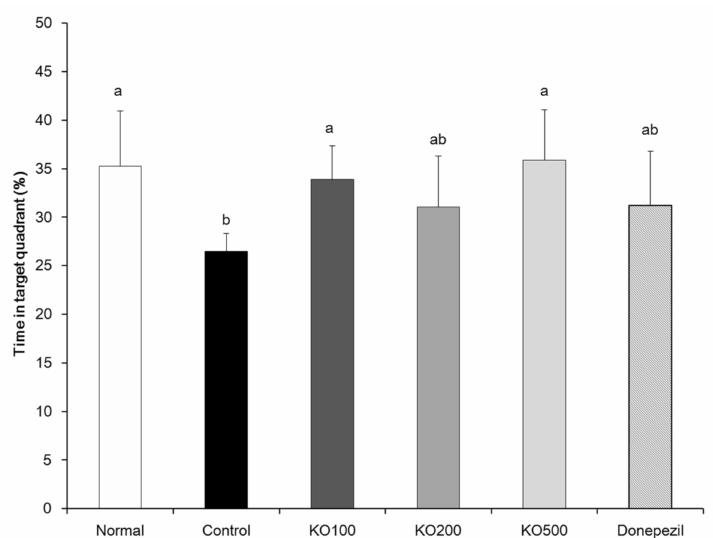
Figure 5. E ff ects of krill oil (KO) on learning and memory impairments in the Morris water maze test. Normal, injection of saline solution + oral administration of water; Control, injection of A β 25–35 + oral administration of water; KO100, injection of A β 25–35 + oral administration of KO at 100 mg / kg / day; KO200, injection of A β 25–35 + oral administration of KO at 200 mg / kg / day; KO500, injection of A β 25–35 + oral administration of KO at 500 mg / kg / day; Donepezil, injection of A β + oral administration of 25–35 donepezil at 5 mg / kg / day. Values are represented as means ± SD ( n = 8). a,b Means with the di ff erent letters are significantly di ff erent ( p < 0.05) by Duncan’s multiple range test. a,b Means with the same letters such as a and b are not significantly di ff erent ( p < 0.05) by Duncan’s multiple range test.